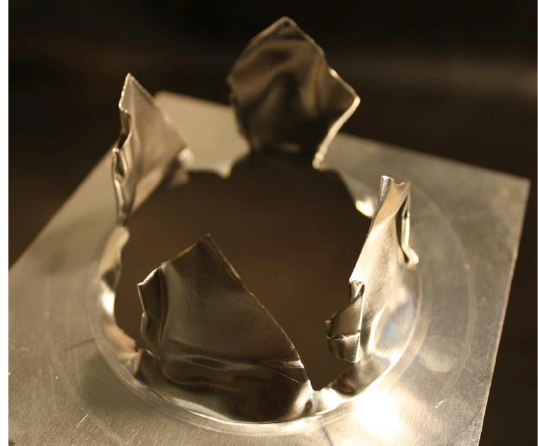
Fig. 12. Burst aluminum